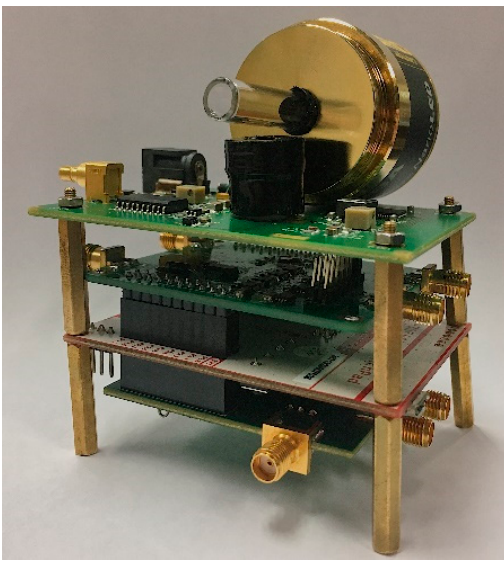
Figure 4. Photograph of the proposed TCSPC system, measuring 7.3 × 6.1 × 9.2 cm 3 .